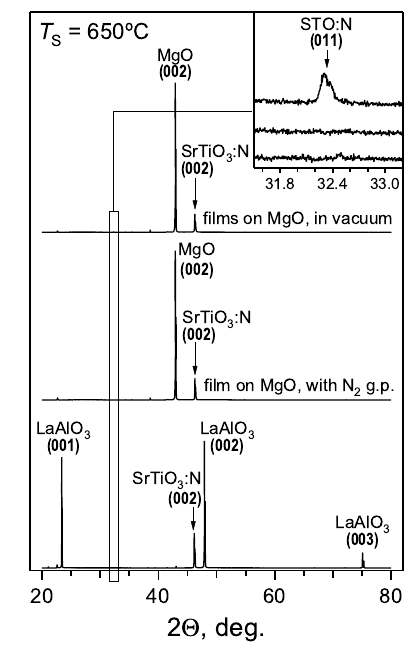
Figure 2. Θ -2 Θ diffraction patterns along the c -axis of films grown on (001)-oriented MgO and LaAlO substrates. The insert shows the detailed region around the (011) film 3 exhibit a single (001) out-of-plain orientation, while reflection. Films grown on LaAlO 3 some films deposited on MgO reveal a mixed-oriented growth.